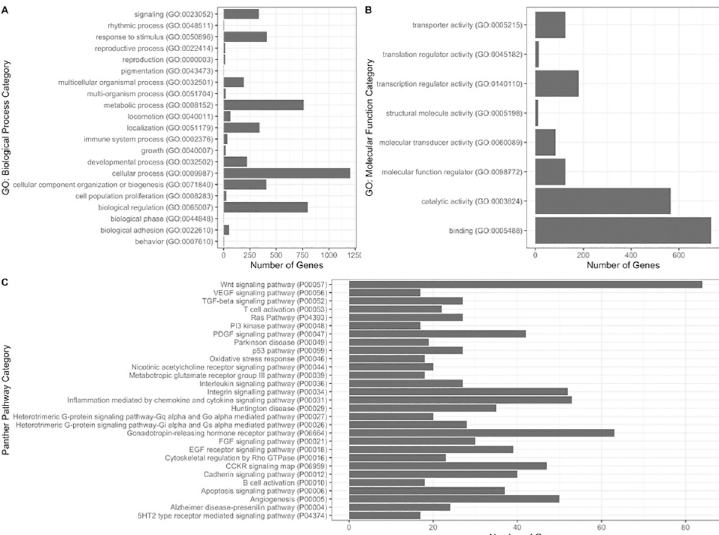
Fig 2. Distribution of genes in Gene Ontology categories. A. Number of genes in GO Biological Categories. B. Number of genes in GO Molecular Function. C. Number of Genes in PANTHER Pathways.